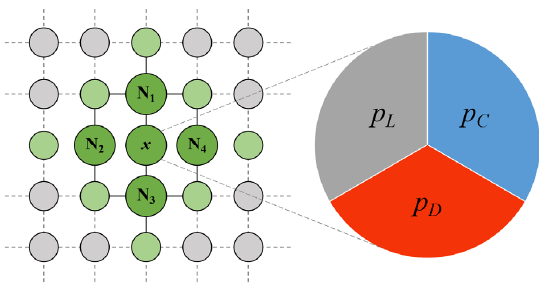
Figure 2. Schematic diagram of the asynchronous updating process.